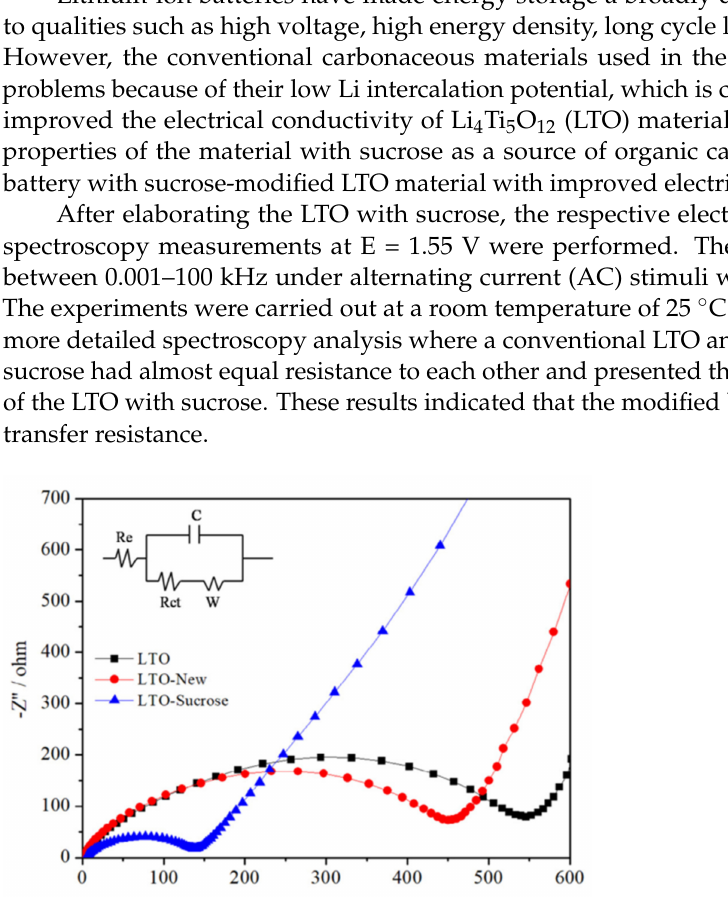
Figure 10. Electrochemical impedance spectroscopy between conventional LTO, LTO manufactured without sucrose, and LTO modified with sucrose [31]. No changes were made to the original figure. The initial charge–discharge curves of sucrose-modified LTO and LTO samples de- veloped in ranges of 100–200 mA/g showing efficiencies of 90.2% and 92.1%,